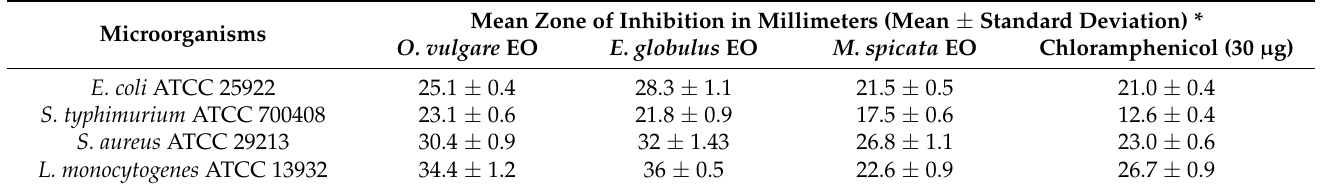
Table 3. The inhibitory diameters (mm) of EOs of O. vulgare, E. globulus, and M. spicata compared to chloramphenicol (30 µ g/disc).